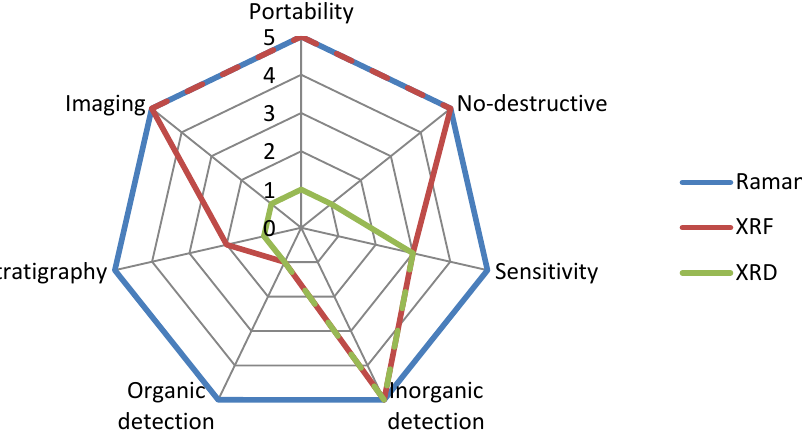
Figure 1. Comparison of some relevant characteristics associated to three different experimental techniques: Raman (blue), X-ray fluorescence (XRF) (red), and X-ray diffraction (XRD) (green).